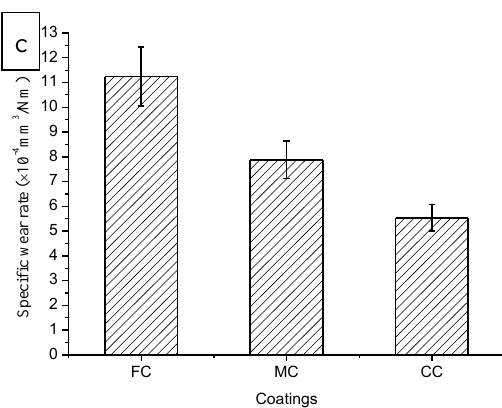
Figure 7. Specific wear rate of the three WC-20Cr 3 C 2 -7Ni coatings ( a ) three-body abrasive wear (180-mesh SiO 2 abrasive); ( b ) three-body abrasive wear (180-mesh SiC abrasive); ( c ) two-body abrasive wear (180-mesh SiC sandpaper).